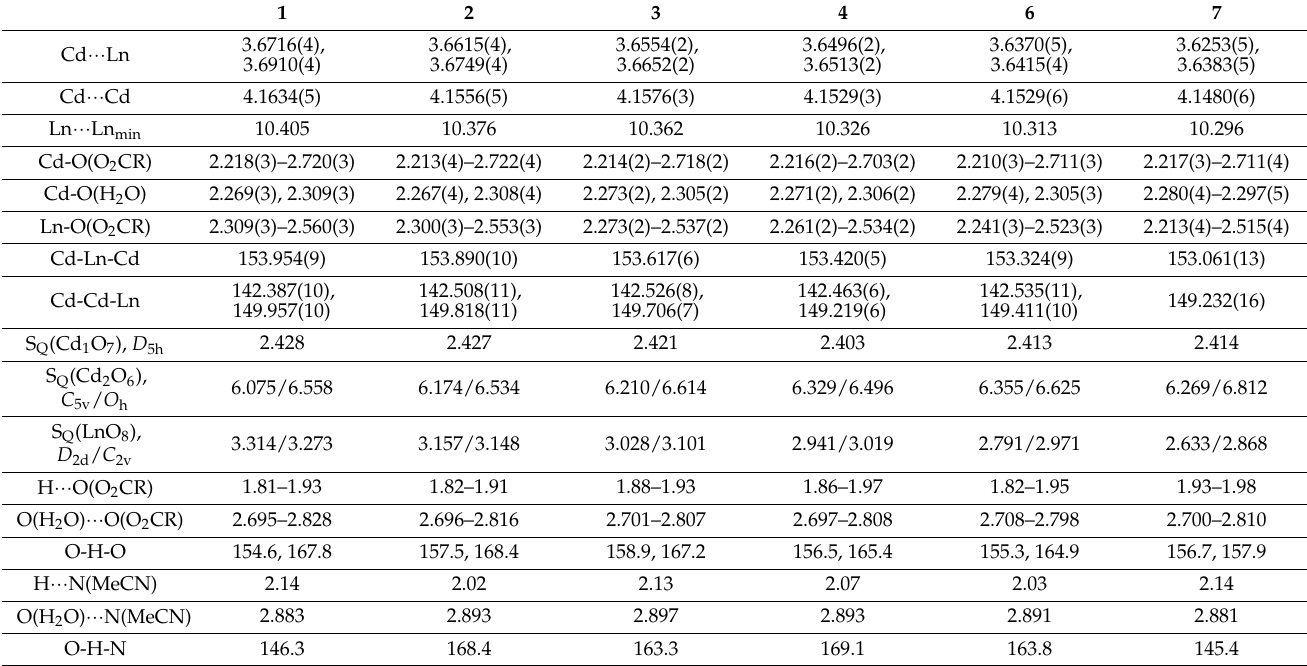
Table 1. Selected bond lengths, the shortest interatomic distances [Å], and angles [ ◦ ] for compounds 1 – 4 , 6 , and 7